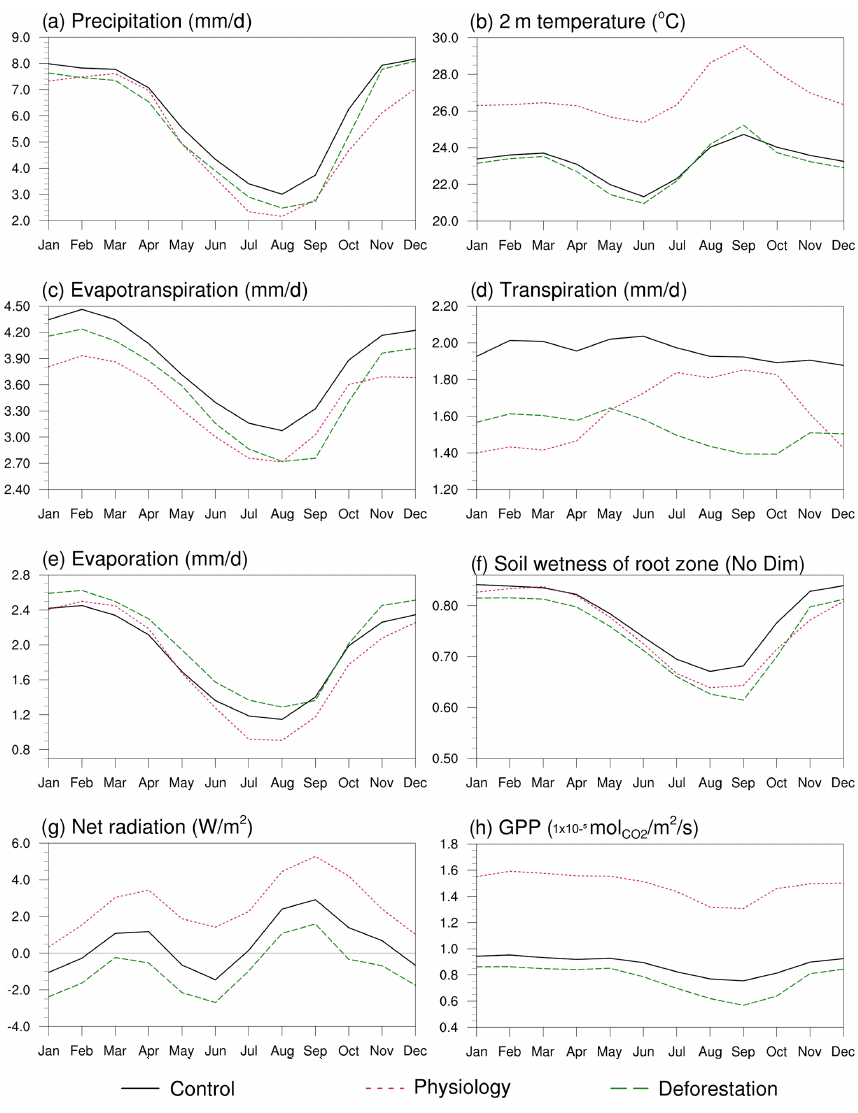
Figure 6. Mean monthly precipitation (a) , 2m temperature (b) , evapotranspiration (c) , transpiration (d) , evaporation (e) , topsoil water content (f) , net radiation (g) and gross primary productivity (h) in the Amazon region (black line square area in Fig. 5) in the Control, Physiology and Deforestation modelling